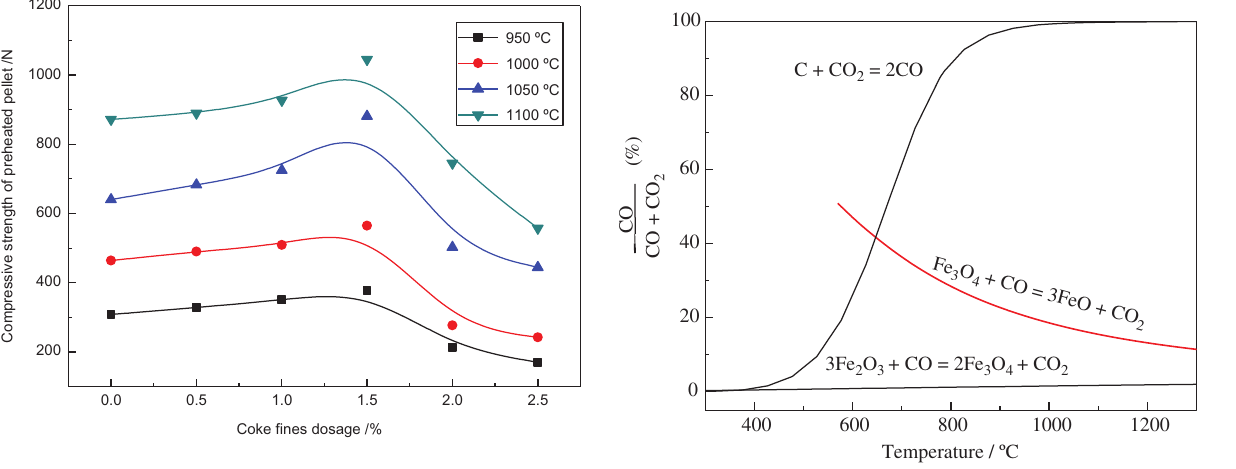
Figure 4: Equilibrium diagram of reduction of iron oxide by carbon